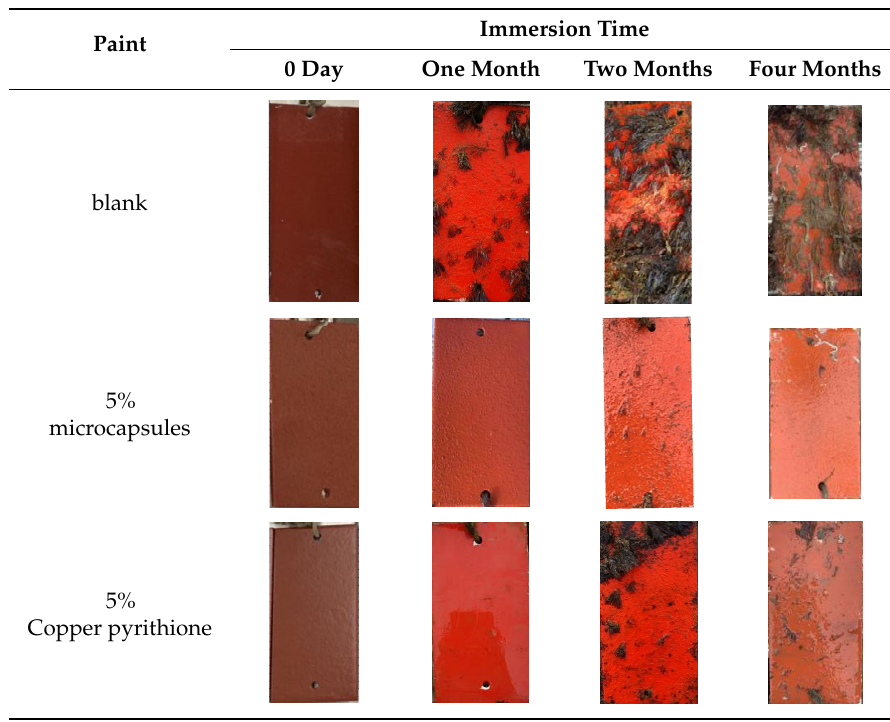
Table 3. Photos of the real ‐ sea tests.